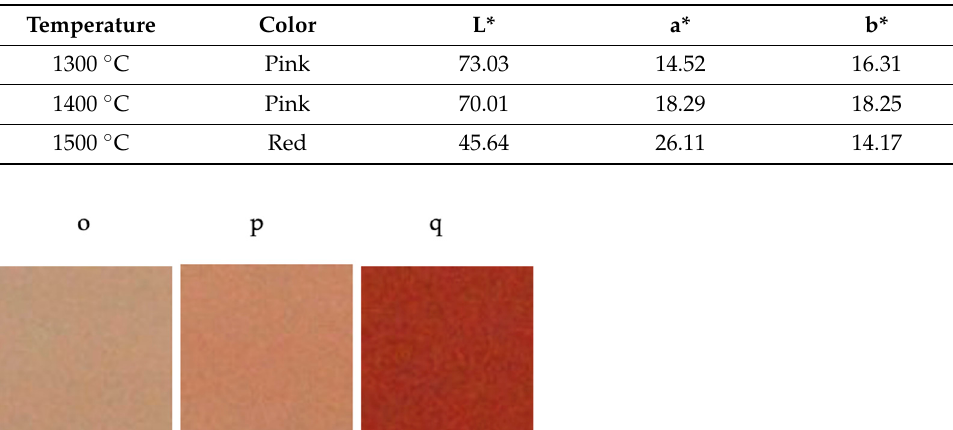
Figure 10. Color development of glazed tiles with pigment Y 0.98 Al 0.98 Cr 0.04 O 3 fired at different temperatures ( o ) 1300 °C; ( p ) 1400 °C; ( q ) 1500 °C.